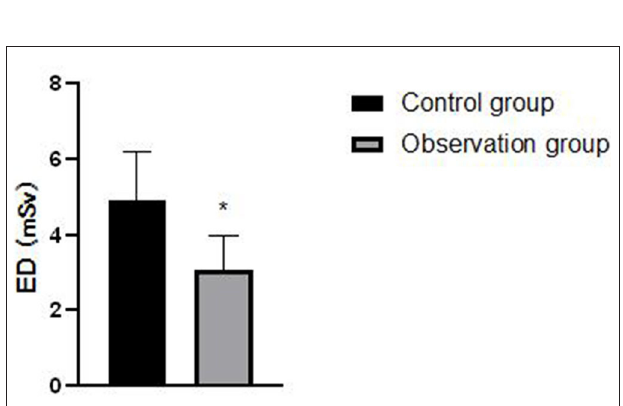
FIGURE 7 | Comparison of contrast agent dosage between the two groups of patients. Compared with the control group, * P < 0.05.